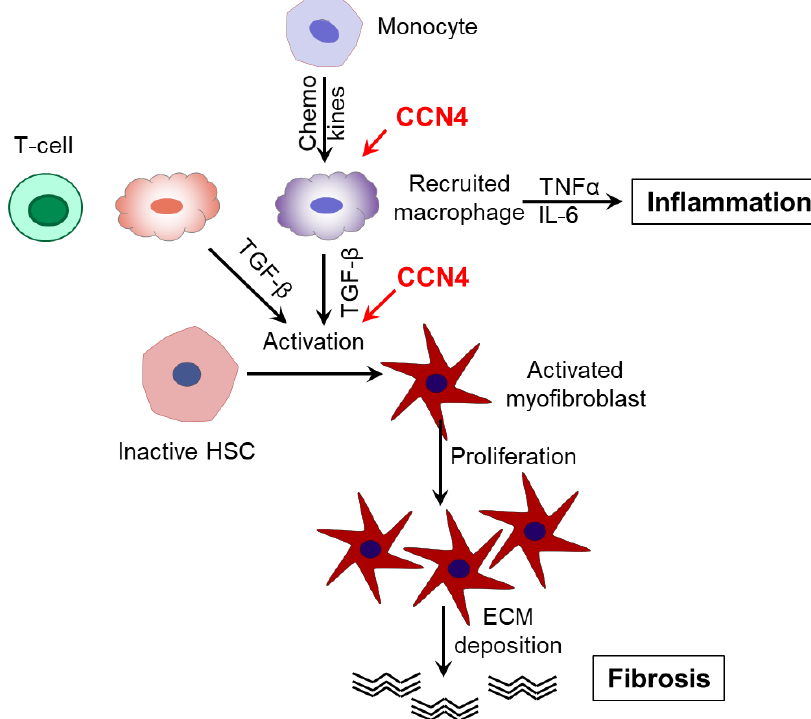
Figure 4. A hypothesized role of CCN4 in the pathogenesis of liver fibrosis. Both immune cells and so-called hepatic stellate cells play a key role in the pathogenesis of liver fibrosis. Upon metabolic disturbances, infiltrated T-cells, macrophages, and other immune cell types, as well as the liver-resident macrophages, induce the activation of HSC, their proliferation, and ECM deposition. CCN4 might accelerate both HSC activation and liver inflammation contributing in this way to the aggravation of liver fibrosis.